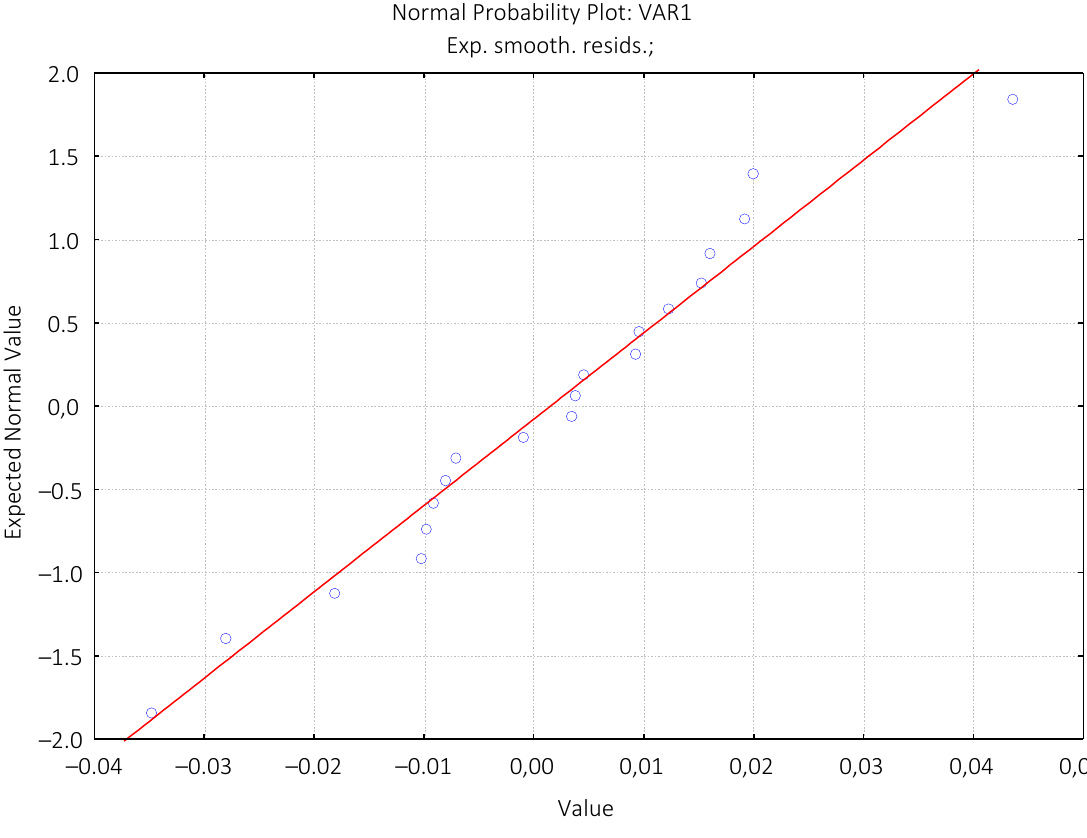
Figure 6. Normal probability plot Table 9. Indicators of actual and forecast values of the level of Ukraine’s financial security Source: Own elaboration in Statistica.